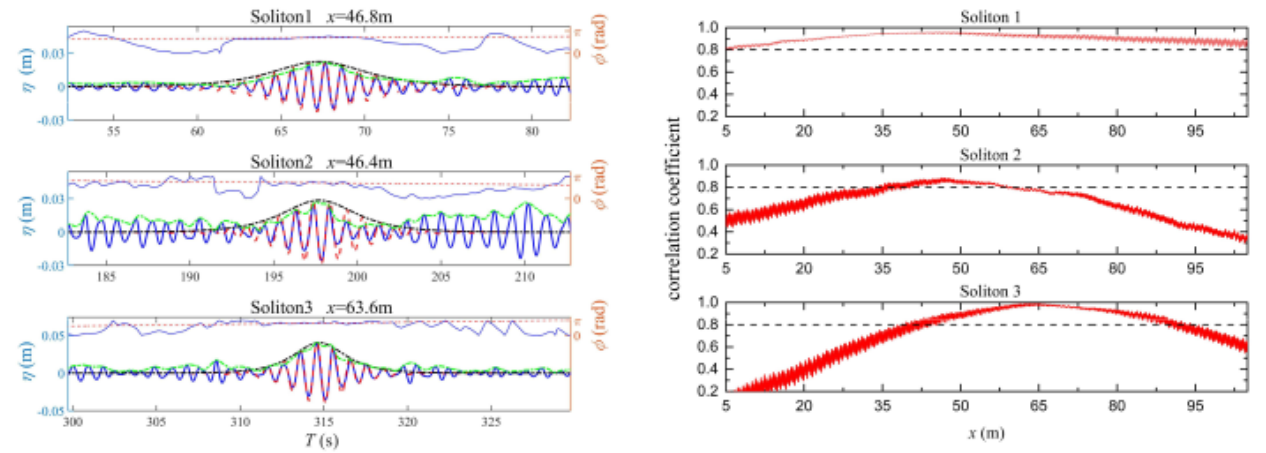
Figure 5. Left : Comparison between the detected soliton (blue solid line) and the theoretical envelope soliton profile (red dashed line). The black dashed line is the envelope of theoretical soliton. The green dashed line is the envelope of detected soliton. Right : Correlation coefficient between three wave groups and the theoretical solitons (red solid line) and the threshold to be successful solitons (black dashed